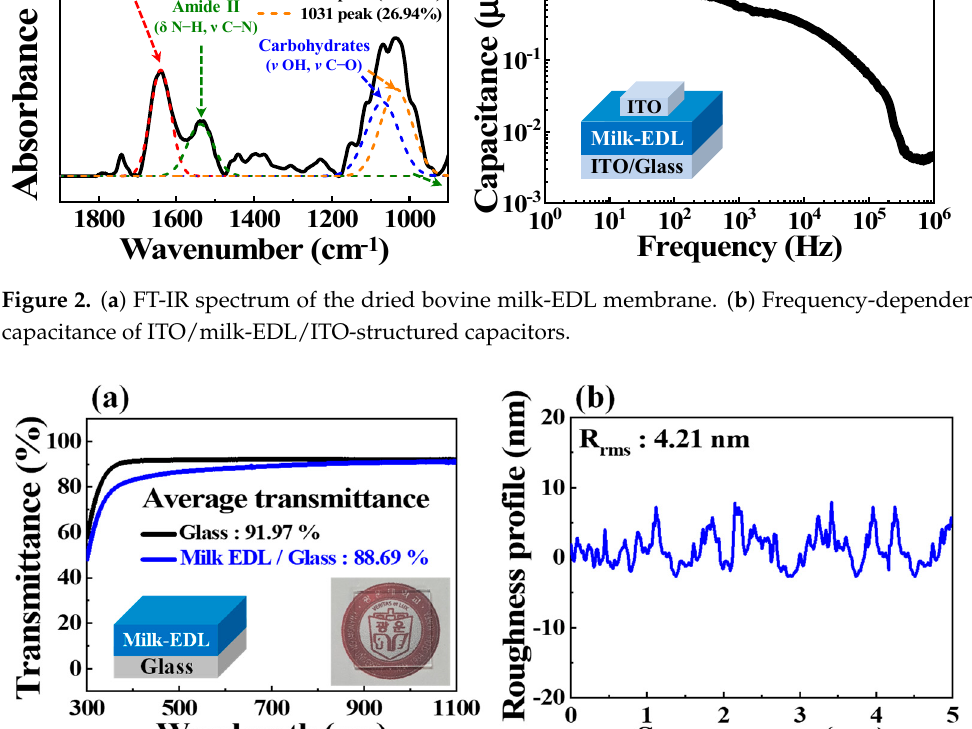
Figure 3. ( a ) Optical transmittance of bovine milk polymer-EDL membrane on a glass substrate. ( b ) Surface roughness properties of bovine milk polymer-EDL membrane. Table 1. Thickness benchmark of protein-based materials applied as EDL of synaptic